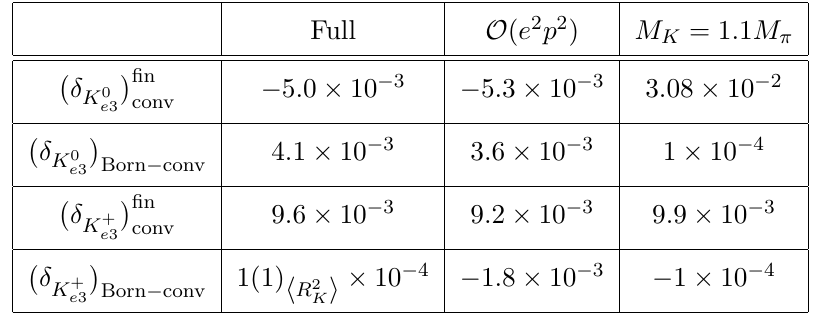
Table 1 . The IR-finite Born contribution to δM 2 + δM a